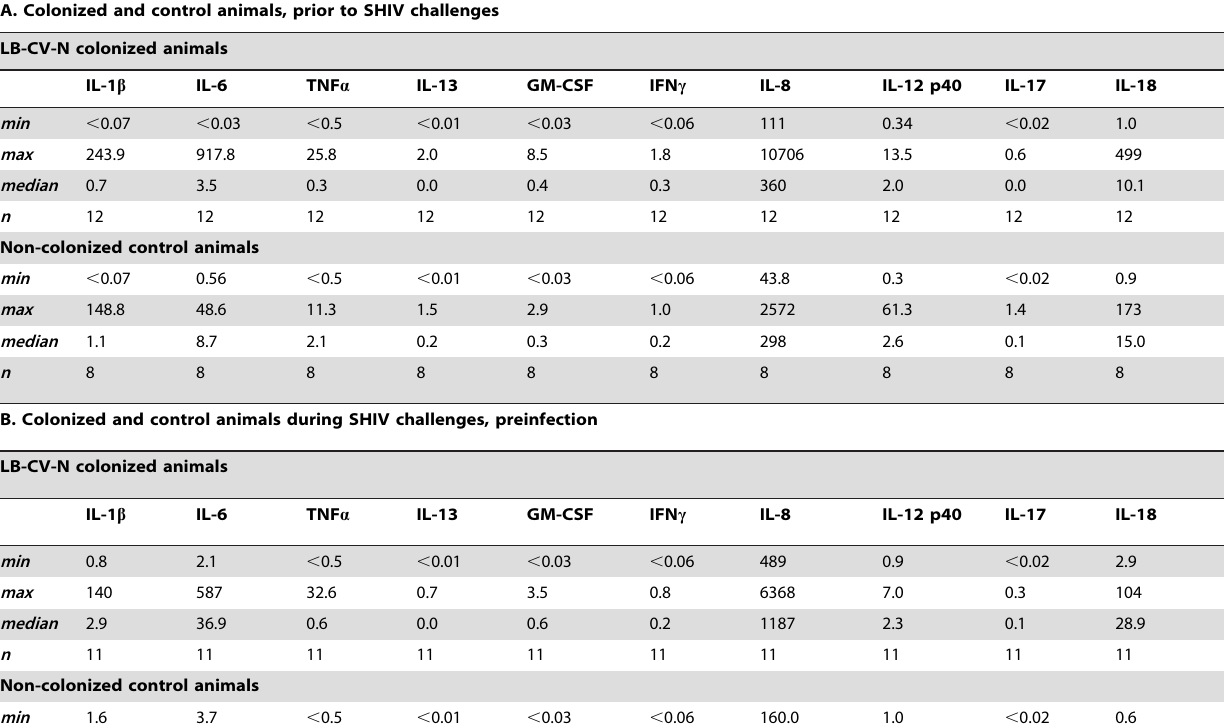
Table 1. Pro-inflammatory cytokine levels in CVL